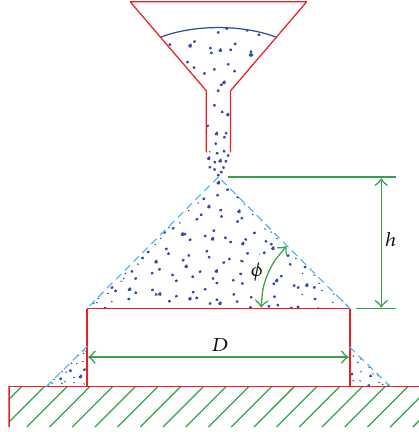
Figure 2: Measurement of angle of repose of